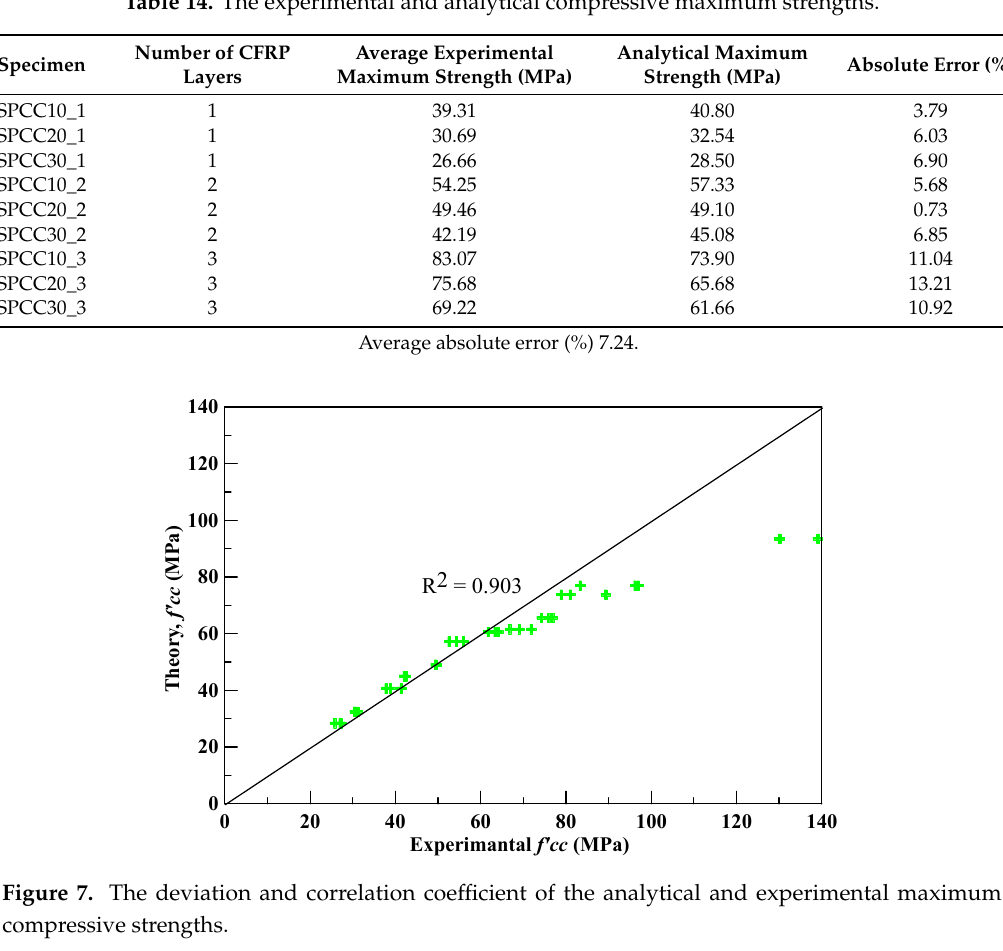
Table 14. The experimental and analytical compressive maximum strengths.